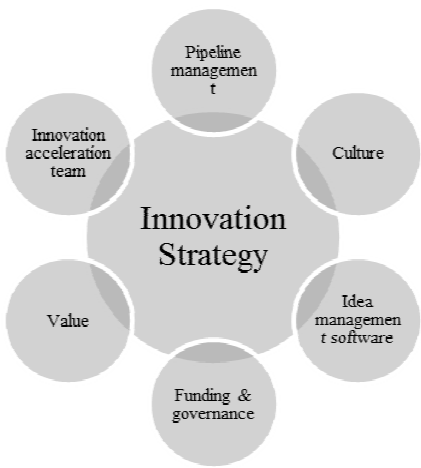
Fig. 3. The first innovation